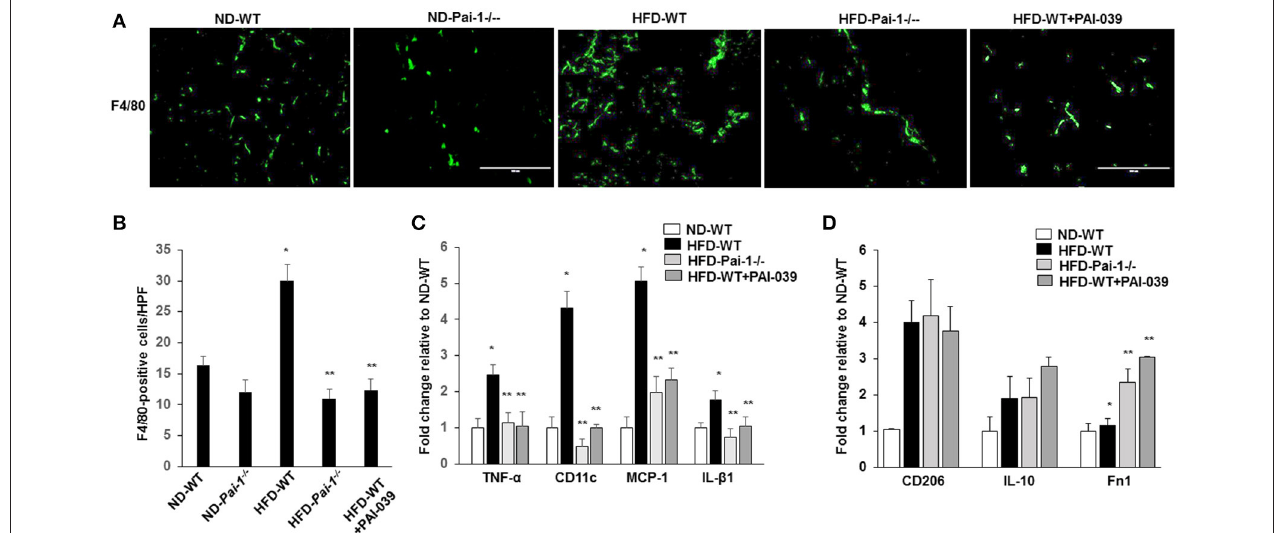
FIGURE 3 | Macrophage quantification in white adipose tissue. (A) Representative images of macrophages as assessed by F4/80 Immunofluorescence in eWAT from ND-WT, ND- Pai-1 − / − , HFD-WT, HFD- Pai-1 − / − , and PAI-039-treated mice. Scale bars, 100 µ m. HPF: high power field. (B) Quantification of anti-F4/80 positive-macrophage infiltration of eWAT. * P < 0.05 vs. ND-WT; ** P < 0.05 vs. HFD-WT. (C,D) The gene profile of the M1 (C) and M2 (D) phenotype as assessed by quantitative RT-PCR of eWAT in ND-WT, HFD-WT, HFD- Pai-1 − / − , and PAI-039-treated mice, respectively. All bars show Mean ± SEM. Data are mean of three experiments and are expressed as fold-control. * P < 0.05 vs. ND-WT; ** P < 0.05 vs.